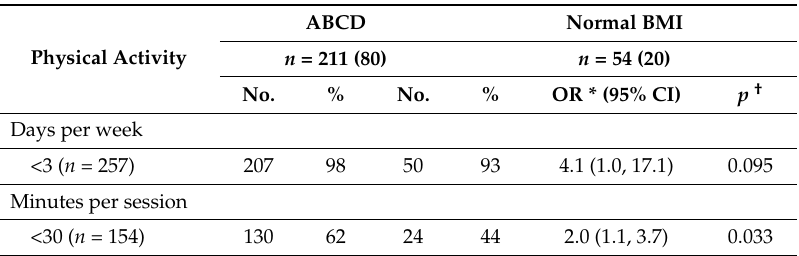
Table 3. Physical activity in ABCD vs. normal